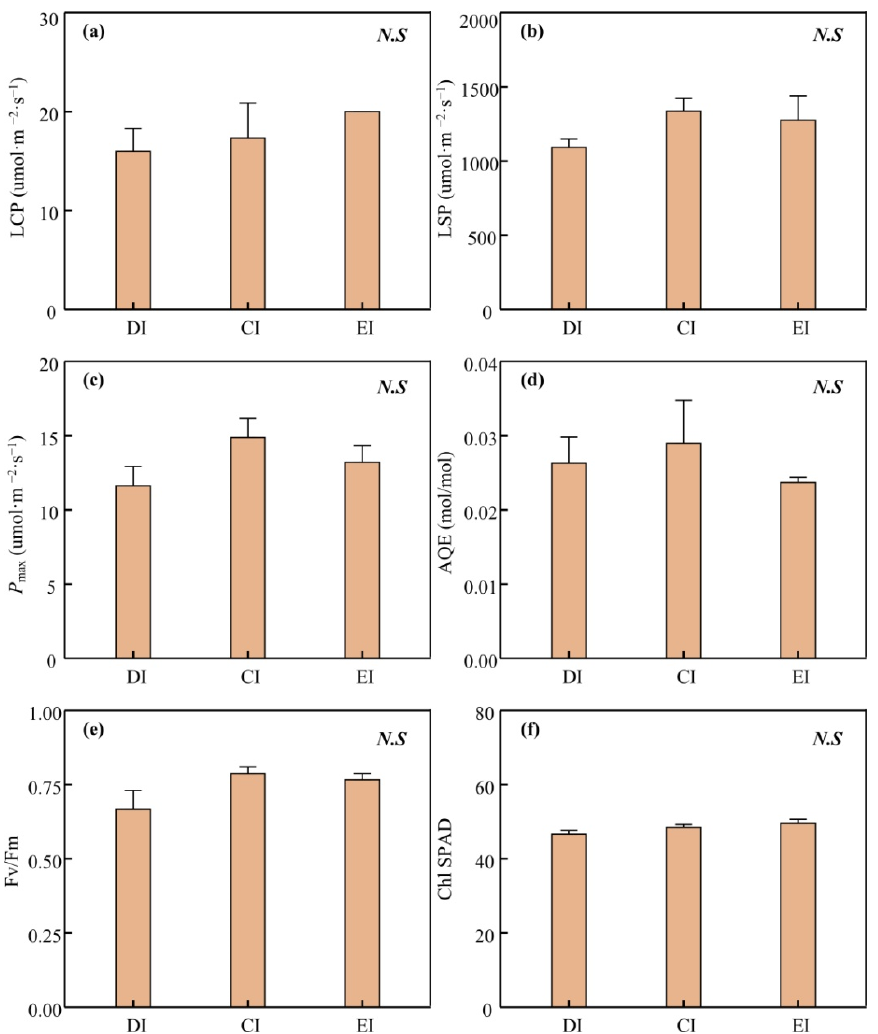
Figure 3. Characteristic parameters of photosynthetic response curves ( a – d ), maximum photo- chemical efficiency ( e ) and chlorophyll SPAD values ( f ) of walnuts under different irrigation treatments. N.S indicates no significant difference between treatments ( p < 0.05, mean ± standard error, n = 3). Soluble sugar content varied among irrigation levels, tree heights and organs (Figure